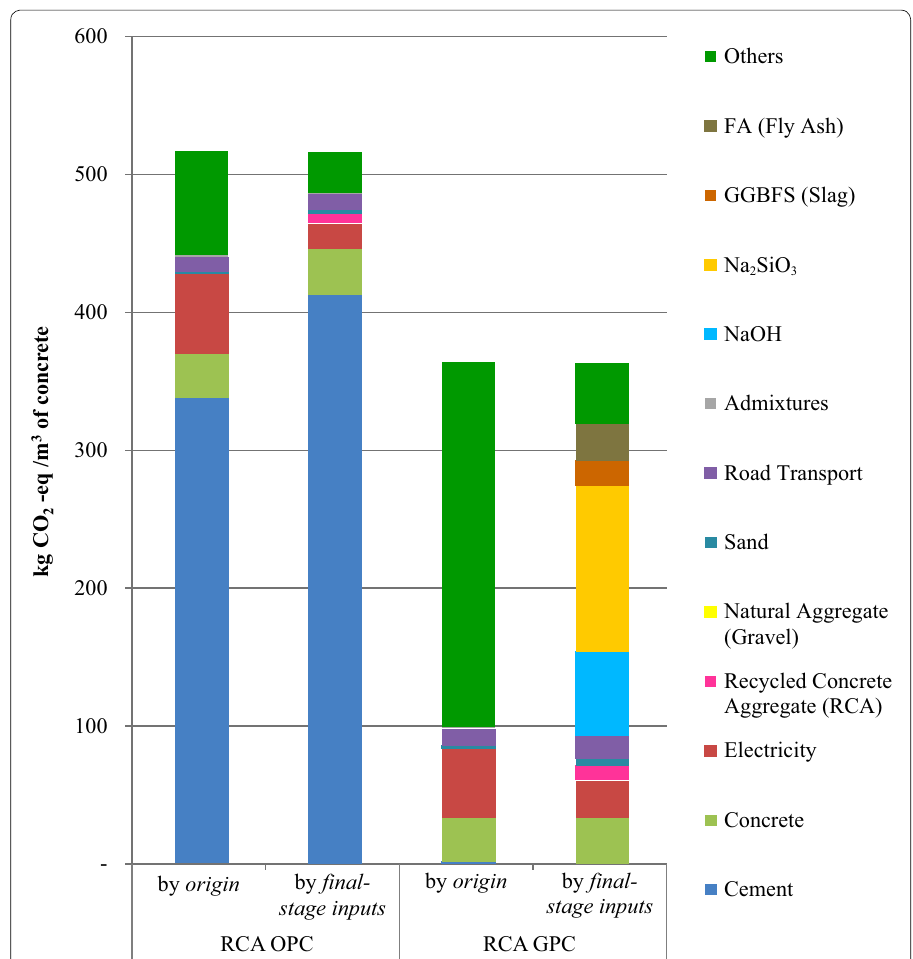
Fig. 8 Decomposition of LCIs by origin and by final - stage inputs for ordinary Portland cement (OPC) concrete and geopolymer concrete